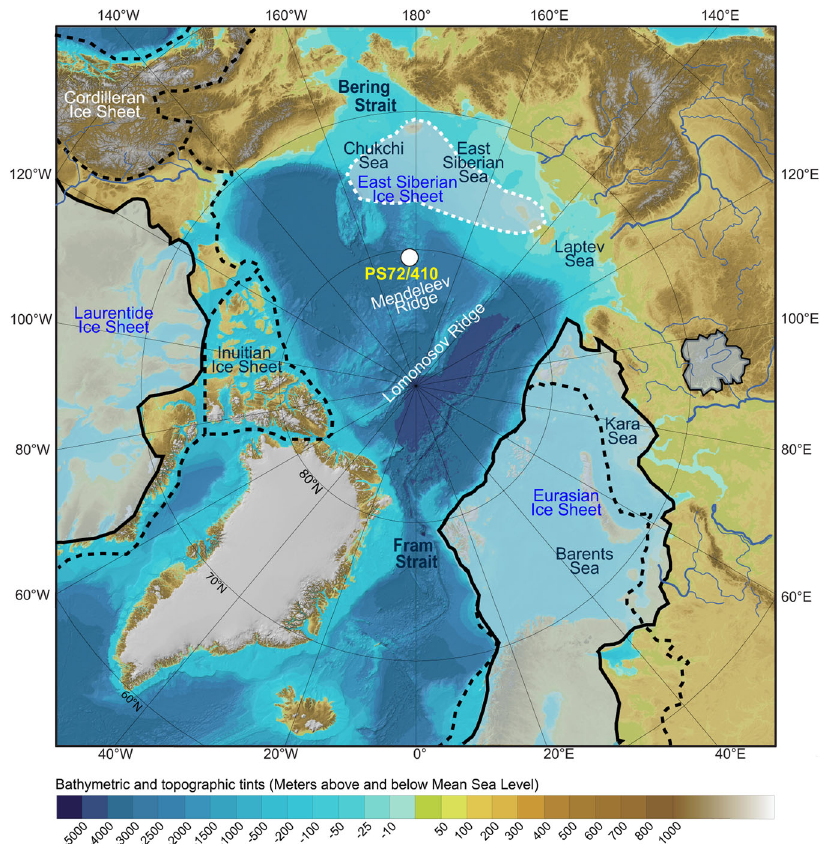
Fig. 1 Location of the study area and sampling locality in the Arctic Ocean. Sediment core PS72/410-1 was collected from the central part of the Mendeleev Ridge in the western Arctic at 80°N at a water depth of 1,800 m during RV Polarstern Arctic Expedition ARK-XXIII/3 (PS72) in 2008 using a giant box corer 15 . The maximum extents of the Laurentide Ice Sheet and Eurasian Ice Sheet during the last glacial maximum (black dotted lines) and MIS 4 (solid black lines) are marked 93 . A white dotted line indicates the Quaternary maximum extent of the marine-based East Siberian Ice Sheet 80 . The bathymetry is taken from IBCAO Ver. 3.0 (ref. 94